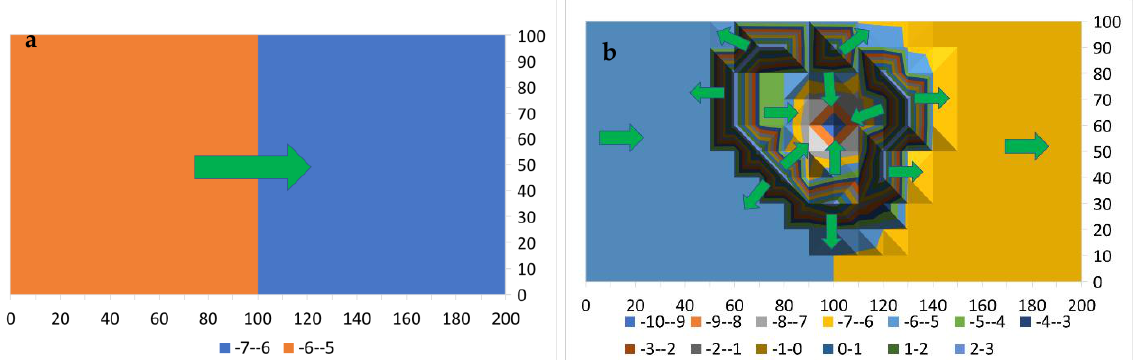
Figure A7. Reconstruction of the aquifer potentiometric surface. ( a ) Initial position; ( b ) Example potentiometric surface associated with a stationary plume. Green arrows = direction of water flow within the aquifer. The x -axis and y -axis scales are spatial coordinates. The z -axis (relative potential values) is represented by the color scheme in the legend.